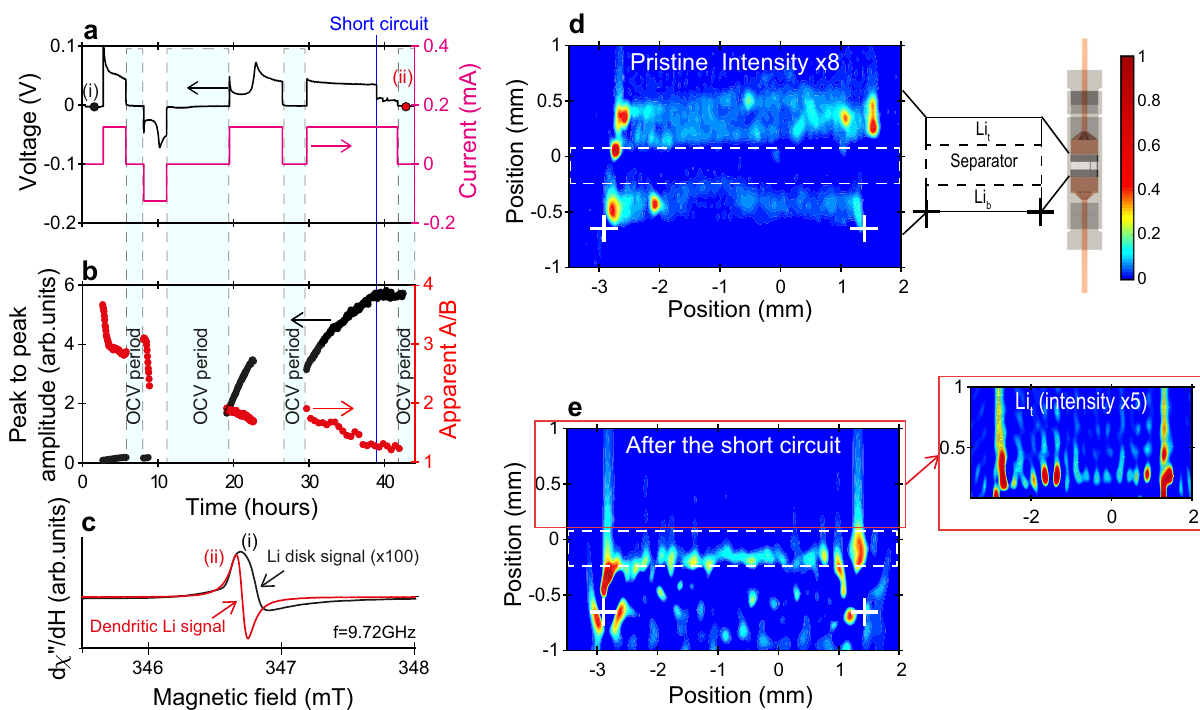
Fig. 4 In situ detection (EPR spectrum) and localization (EPR images) of dendritic Li. a Voltage and current of the electrochemical cell versus time. The vertical blue line indicates the short circuit with a voltage drop to 0 V and current still fl owing in the cell. b Operando peak to peak amplitude and apparent A/B ratio measured on the entire EPR signal (no simulation) as a function of time. 50% of the data are missing for the second and third cycling phase due to clipping effects from a non-optimal receiver gain. c EPR spectra of the cell recorded in the pristine state (bulk Li electrodes) and after the short circuit (dendritic Li). The resonance fi eld is H res = 346.82 mT for the bulk Li signal and H res = 346.7 mT for the dendritic Li signal. d , e In situ spatial-spatial EPR images recorded in the pristine state (peak to peak amplitude x8) and after the short circuit, respectively. Spots crossing the separator after the short circuit suggest the location of dendritic Li. The inset shows a zoom in the region of the top electrode Li t , not fully consumed. The white crosses are a guide to the eye for the lower part of the bottom electrode. The color bar indicates the color code for the peak to peak amplitudes, identical for all plots. The illustration of the EPR cell has been created by Charles-Emmanuel Dutoit using an open-source 3D computer graphics software (Blender